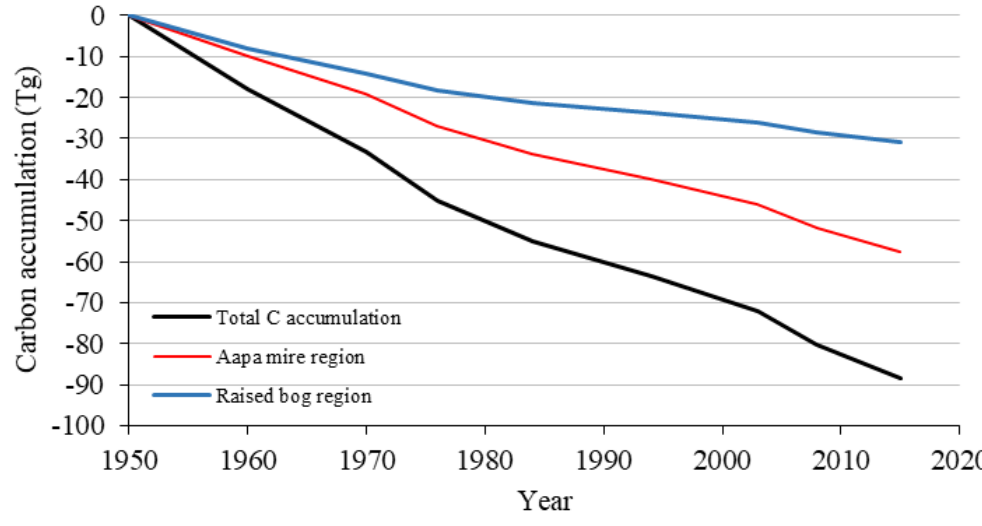
Figure 5. Cumulative C accumulation (Tg) of undrained mire area between 1950 and 2015. The C accumulation in the southern raised bog region and the northern aapa mire region are also shown.